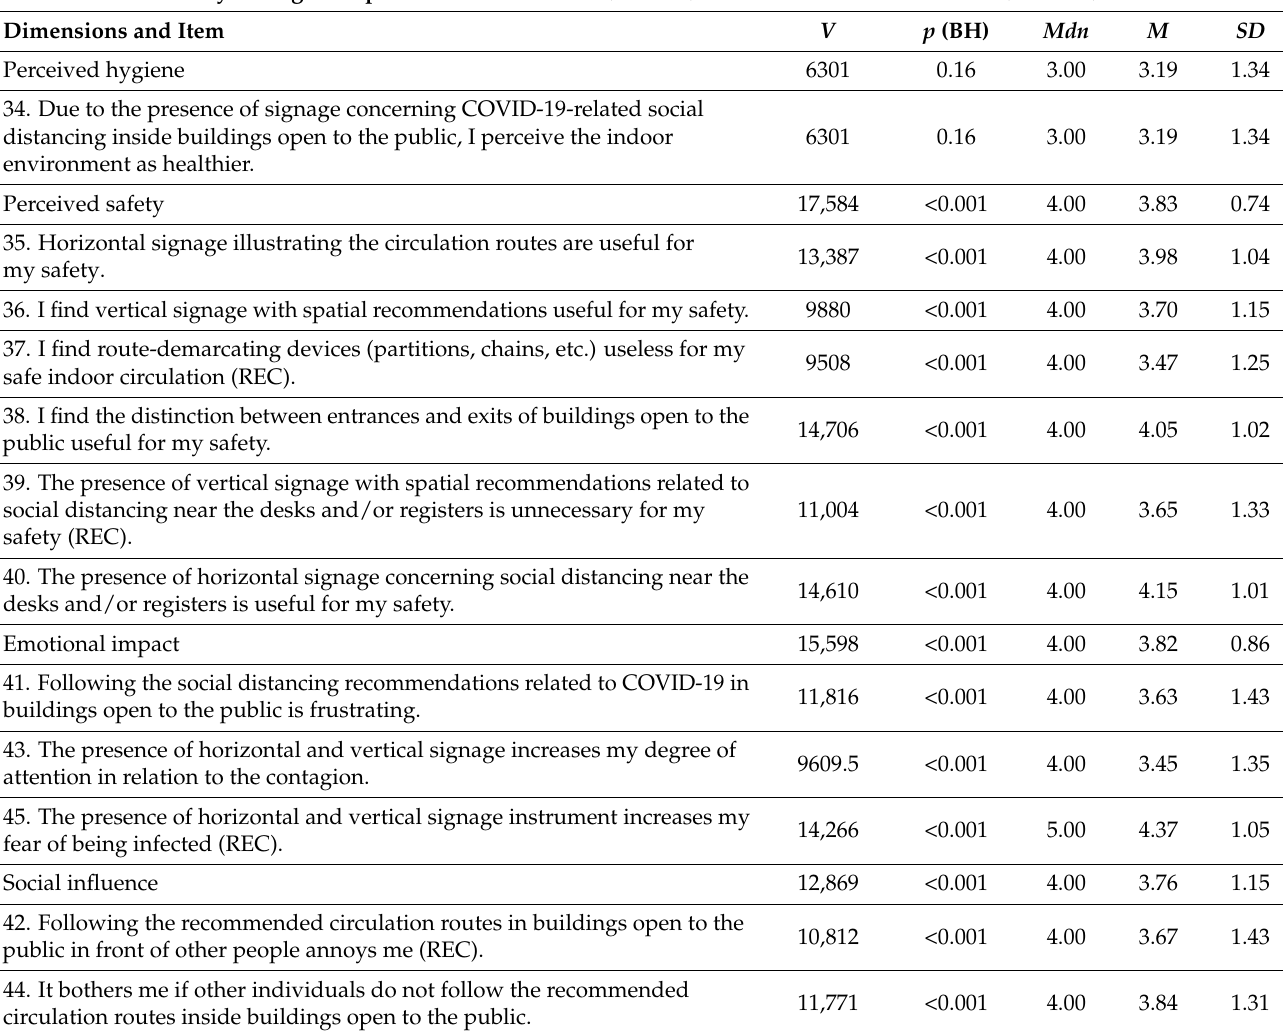
Table A3. Table illustrating the values of Wilcoxon test comparing the scores that participants assigned to each dimension with the median value of the scale ( V , p (BH), median ( Mdn ), means ( M ), and standard deviations ( SD )) reported for the wayfinding. Own